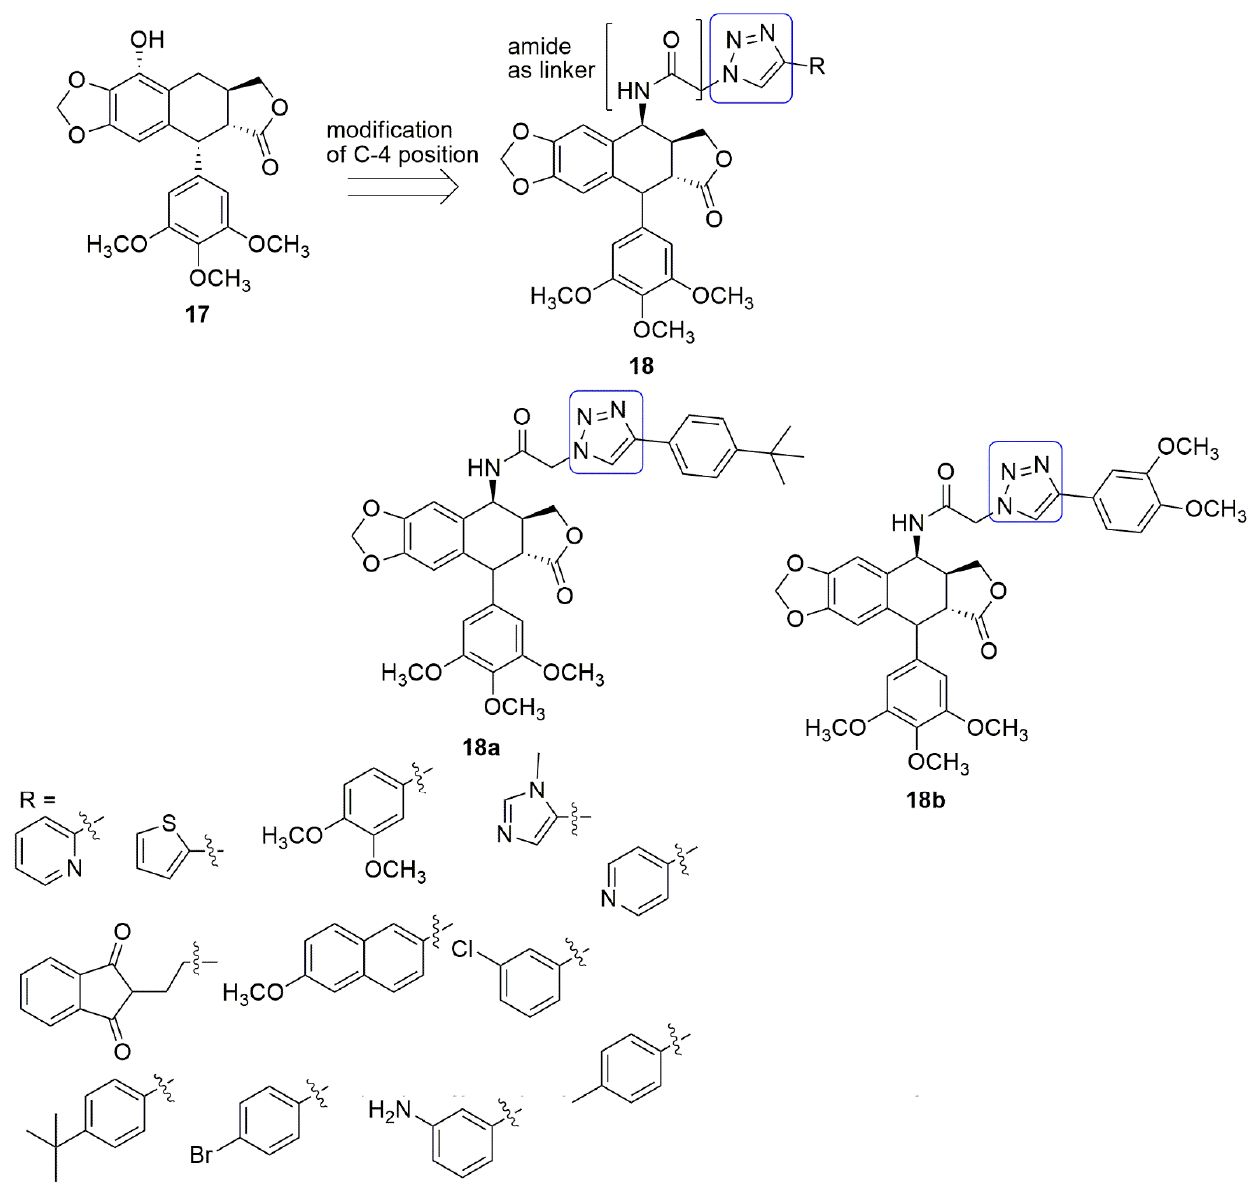
Figure 8. Chemical structures of triazolo-4 β -amidopodophyllotoxin derivatives as promising anti-tubulin agents. A combination of the structure of benzo [b]furan, 19 , 20, and triazole 21 to produce a single molecule has been explored. The hybrid compounds containing benzo[ b ]furan and